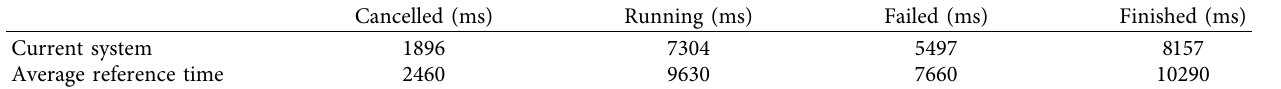
Table 1: State switching time comparison.